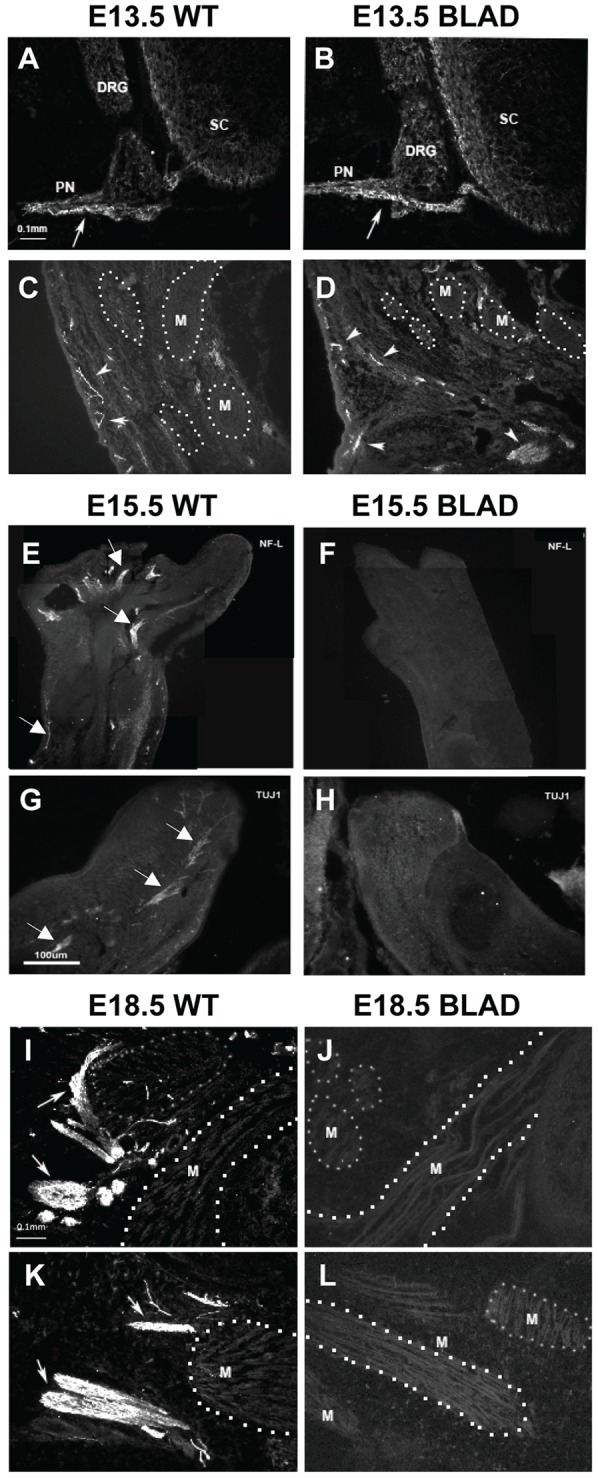
Peripheral innervation of the hind limb.Sections of spinal cord (A, B) and thigh (C, D) in E13.5 WT (A, C) and Nmnat2blad/blad (B, D) showing axons (arrows) exiting the spinal cord and innervating thigh muscles (M) in both WT and Nmnat2blad/blad mice. (Sections were stained with a neurofilament antibody and visualized by immunofluorescence). E–H, sections of the distal limb and foot in E15.5 WT (E, G) and Nmnat2blad/blad (F, H) showing NF+ (E, F) and TUJ1+ (G, H) labeled axons (arrows) in peripheral nerves. I–L, longitudinal sections of thigh muscles (M) of E18.5 WT (I, K) and Nmnat2blad/blad (J, L) mice labeled with a neurofilament antibody to visualize intramuscular axons (arrows). DRG, dorsal root ganglia; PN, peripheral nerve; SC, spinal cord; M, the unlabeled background in images of the limbs largely represents muscles many of which are bounded by a dotted line for illustrative clarity.